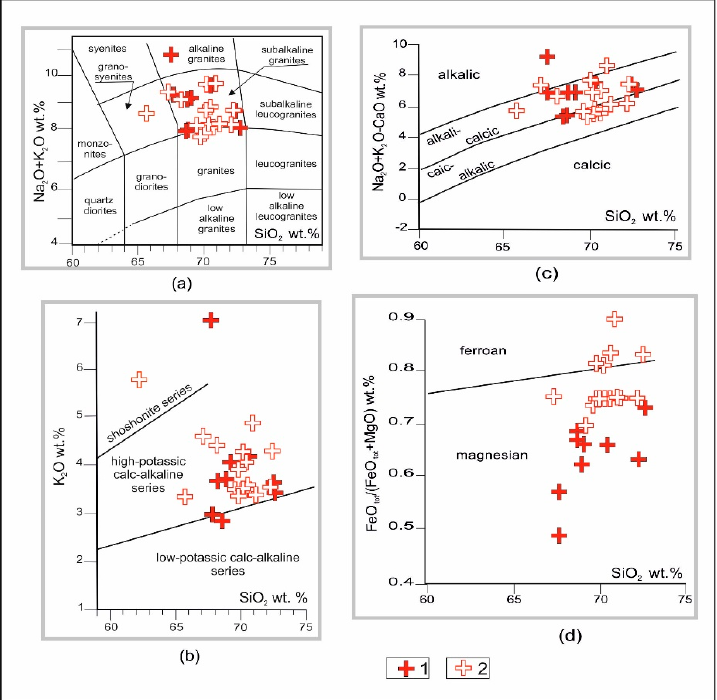
Figure 2. Petrochemical characteristics of adakite series granitoids on classification diagrams: ( a ) (Na 2 O + K 2 O) − SiO 2 [25]; ( b ) K 2 O − SiO 2 [26]; ( c ) (Na 2 O + K 2 O − CaO) − SiO 2 and ( d ) FeO tot /(FeO tot + MgO) − SiO 2 by [27]. Legend: igneous rocks of the southern (1) and northern (2)